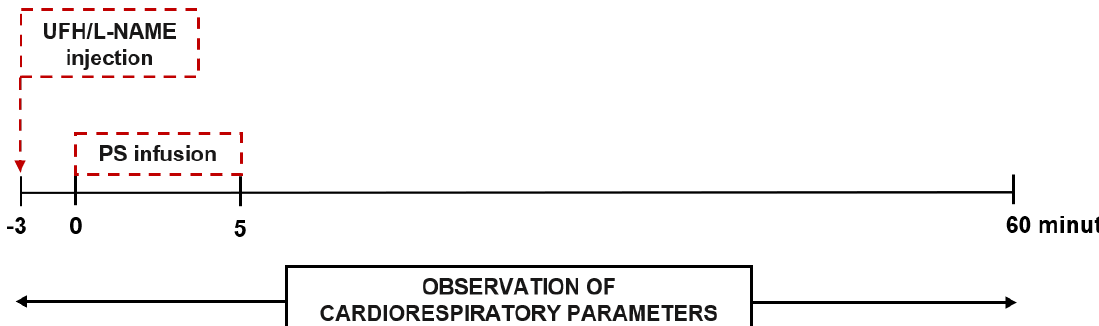
Figure 2. Schematic representation of cardiorespiratory parameters observation in rats treated with unfractionated heparin (UFH) and protamine sulfate (PS), and with N( ω )–nitro– L –arginine methyl ester ( L –NAME) and PS.